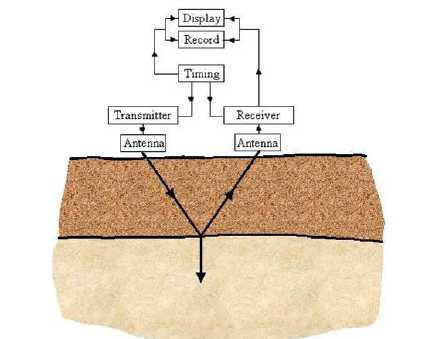
Figure 2. Typical flowchart of a GPR system (Davis and Annan,